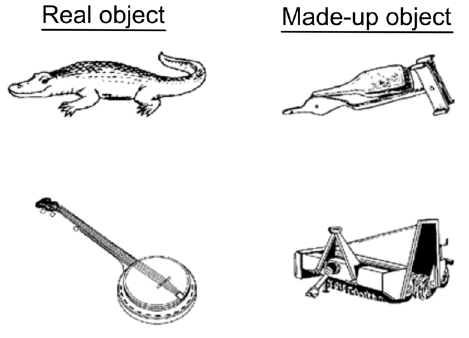
Figure 1. Examples of the real and made-up objects used as stimulus